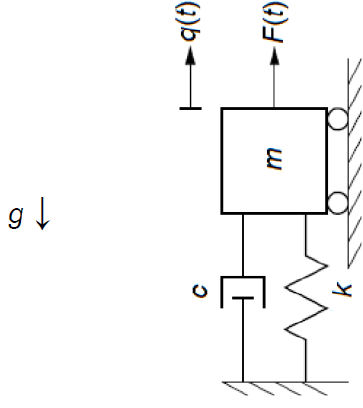
Figure 1. Visualization of the forced mass–spring–damper